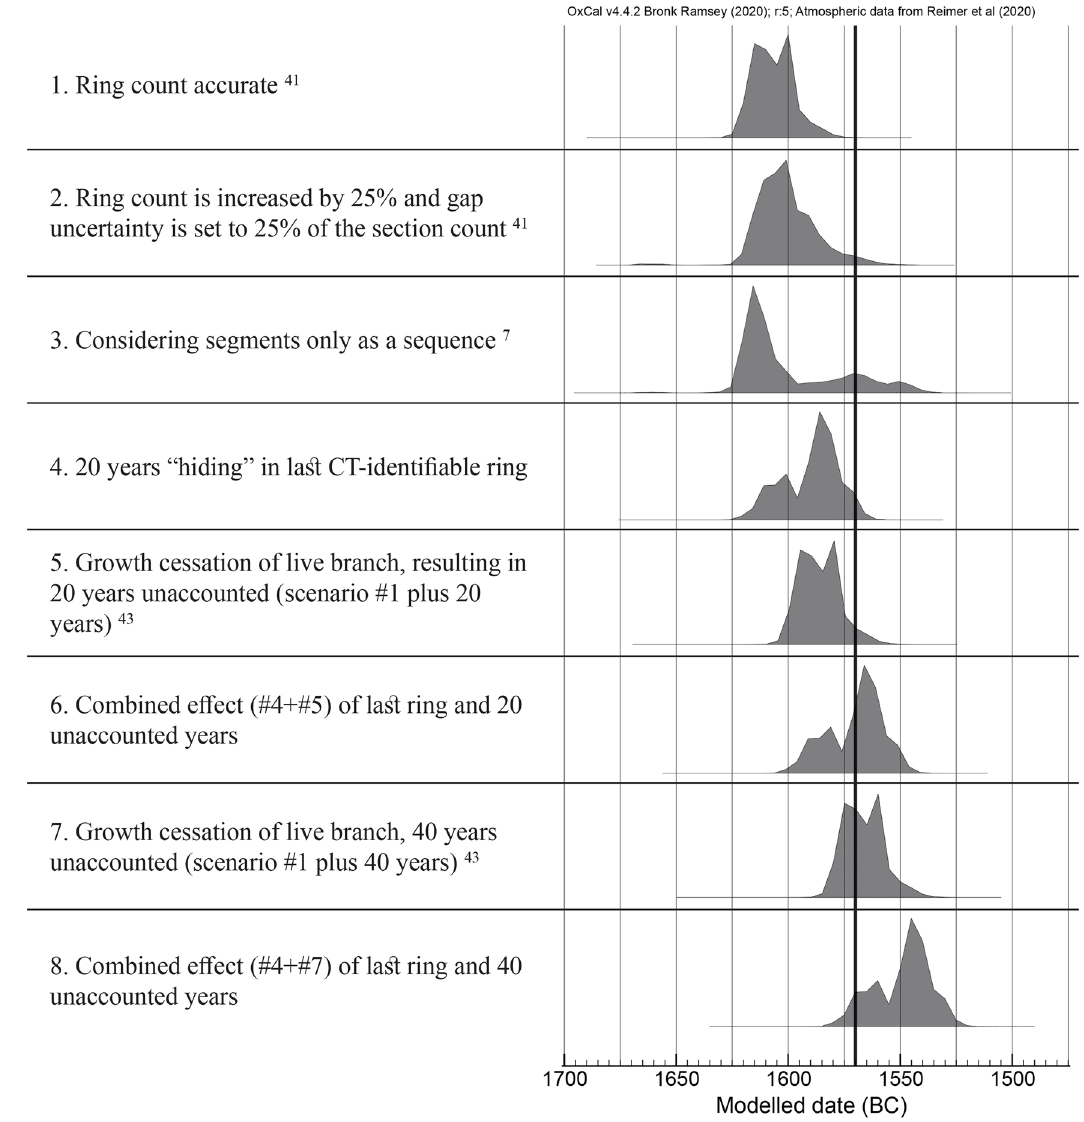
Figure 5. Modeling dating outcomes for the olive branch from Santorini. Given different scenarios based on chronological anomalies we observed in modern olive wood (scenarios 4–8), the radiocarbon date (uncalibrated age of 3331 ± 10) from the last segment of olive wood buried alive under the tephra at Santorini 13 was calibrated and modeled. A bold line marks the date for the beginning of the New Kingdom at 1570